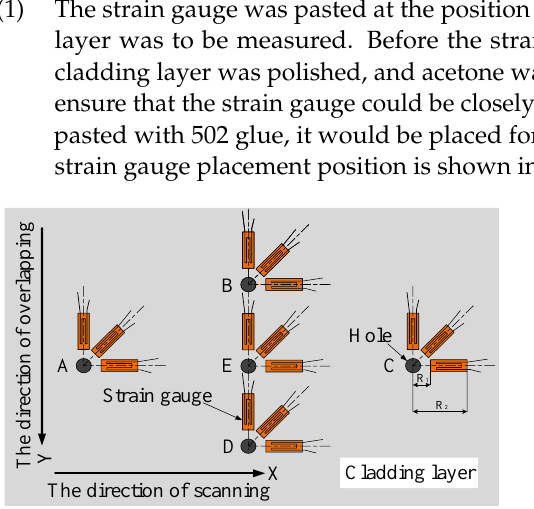
Figure 10. Schematic diagram of residual stress test.